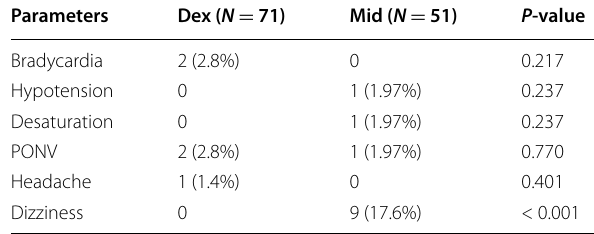
Table 5 Adverse effect on the study